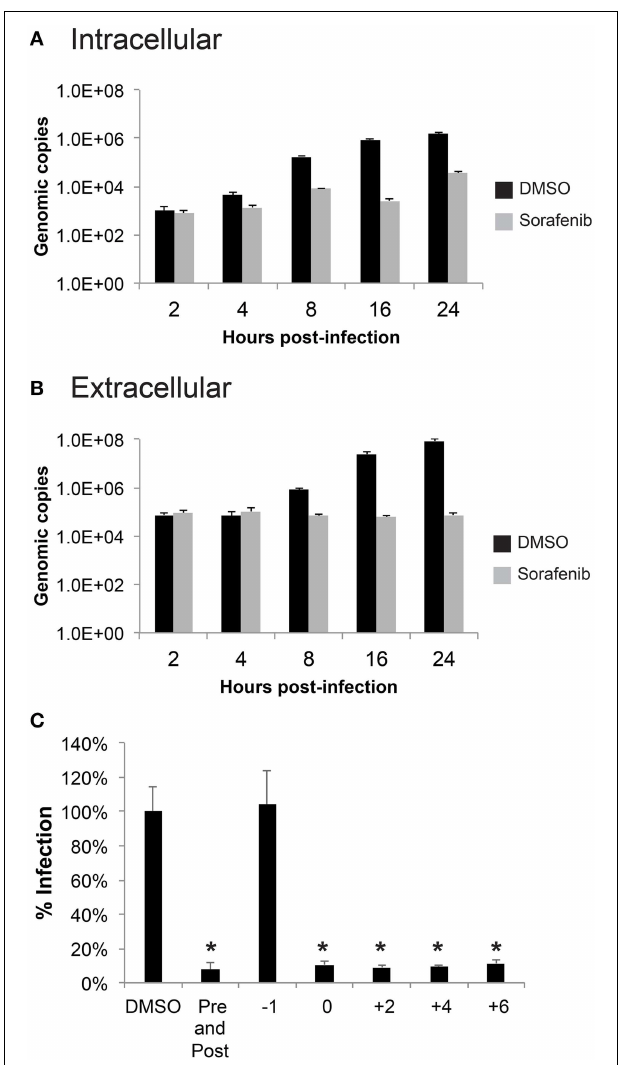
FIGURE 4 | Sorafenib affects an early stage of infection. (A,B) HSAECs were pre-treated, infected and post-treated with either DMSO or sorafenib. Supernatants and lysates in RLT buffer were collected at the indicated times post-infection. RNA was extracted from all samples and a qRT-PCR was performed to determine viral genomic copies. The average and standard deviation of three biological replicates are plotted. (C) HSAECs were treated at various times relative to MP12 1 NSs-Luc infection (1h pre-treatment, at the end of 1h infection, at 2, 4, 6 hpi, both pre-treated and post-treated). Lysates were collected at 24 hpi and analyzed for luciferase activity. Data is graphed in percentage RLU of the DMSO control. * p ≤ 0 . 01 .